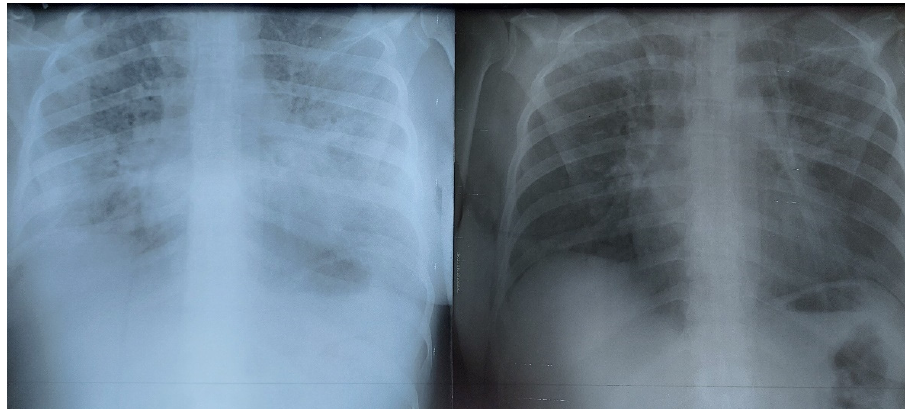
Figure 1. Pregnant patient in the ICU. On the left, Brixia A score 12, qSOFA A score 0. On the right, two days later, Brixia score 14, qSOFA score 1 (respiratory rate over 22 breaths per minute). Patient in the spring group.